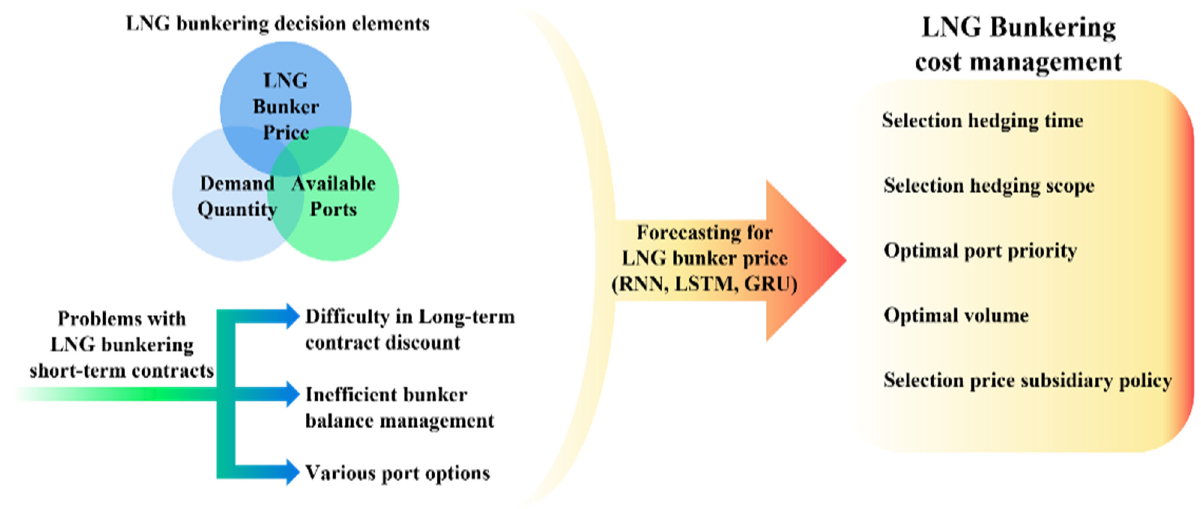
Figure 5. LNG bunkering cost management using short-term forecasting.